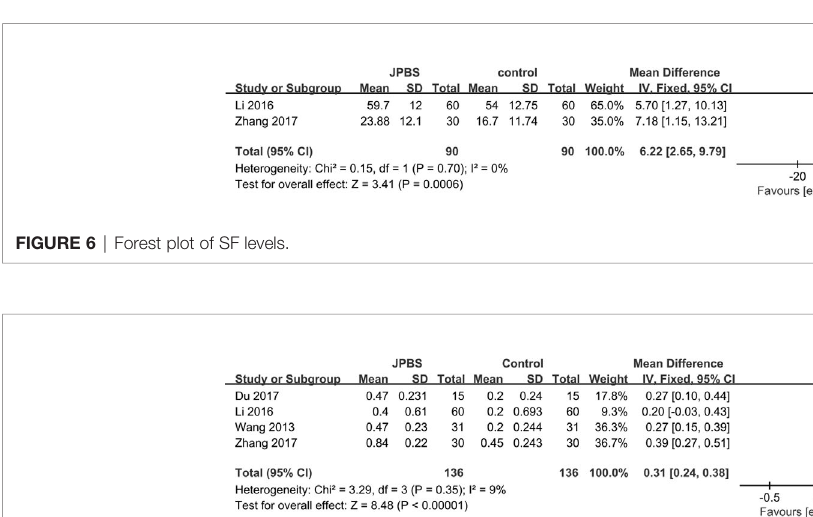
FIGURE 7 | Forest plot of RBC levels.